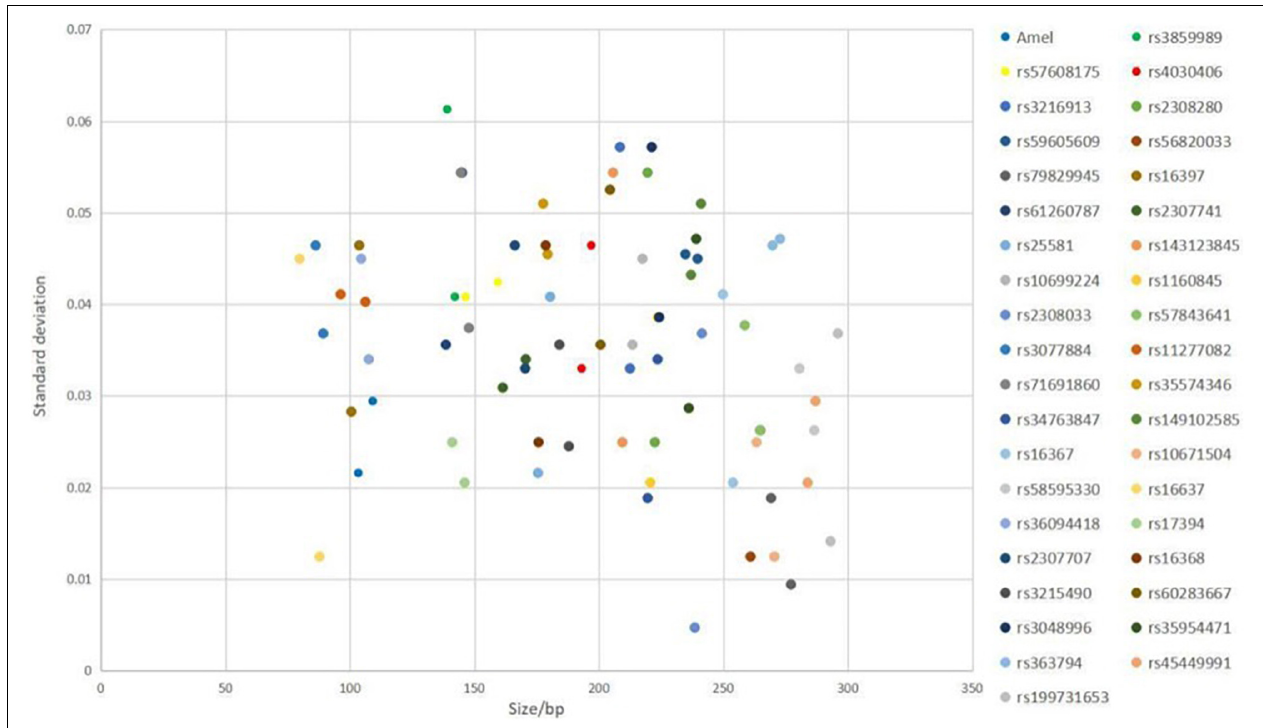
5 µ mol/L, 5/10, and 0.3 µ l in the same order above ( Supplementary Figure 4